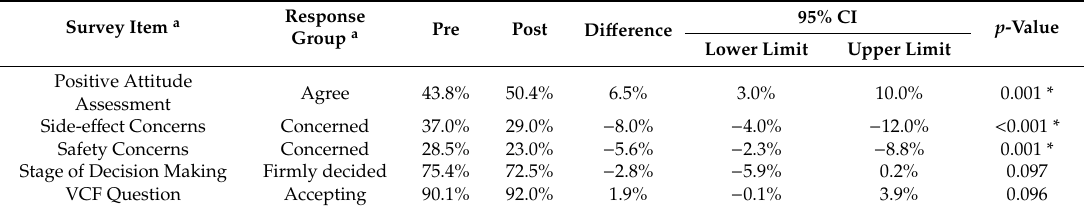
a Refer to Table 1 for a description of survey items and response grouping. * Statistically